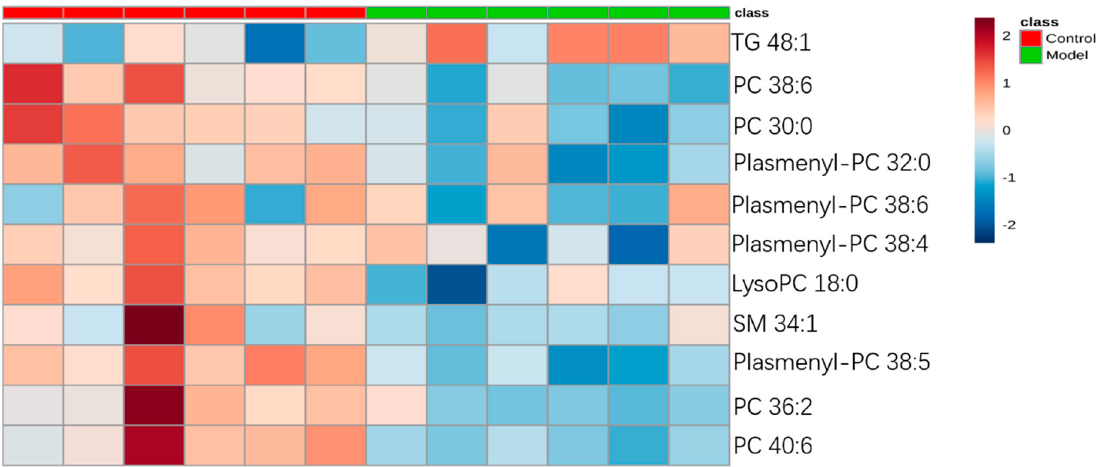
Figure 6. Heatmap of identified differential lipids in BALF (positive ion mode). Each square in the heatmap represents the corresponding intensity value of a phospholipid of samples in each group, red represents the increase in concentration and blue represents the decrease in concentration.